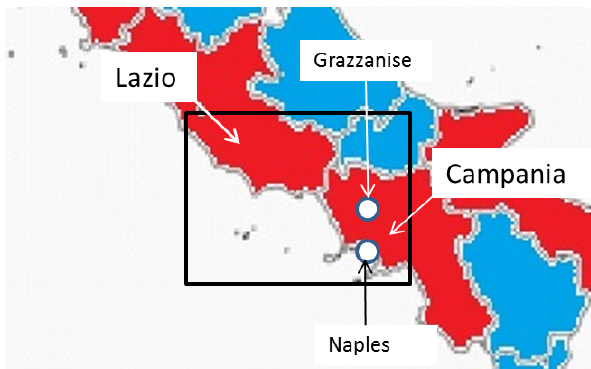
Figure 1. The computational domain with the position of the 2 sta- tions used for the verification (Naples and